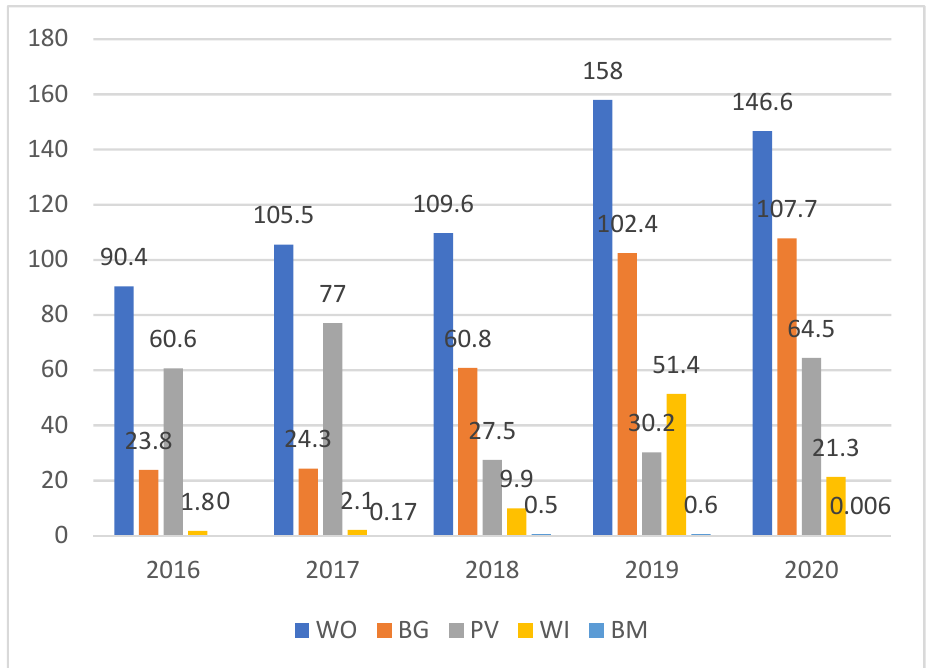
Figure 4. Energy production in small RES installations in 2016–2020 by type of source (in GWh).